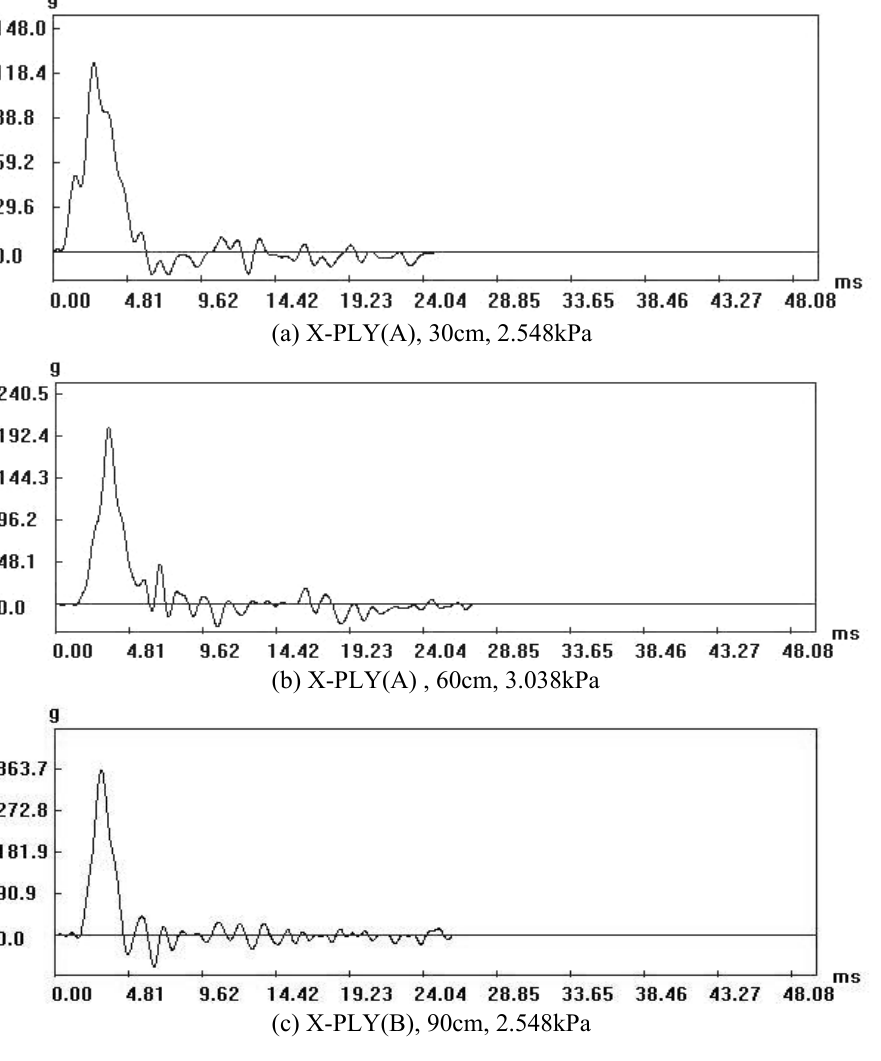
Fig. 4. Drop shock acceleration and time